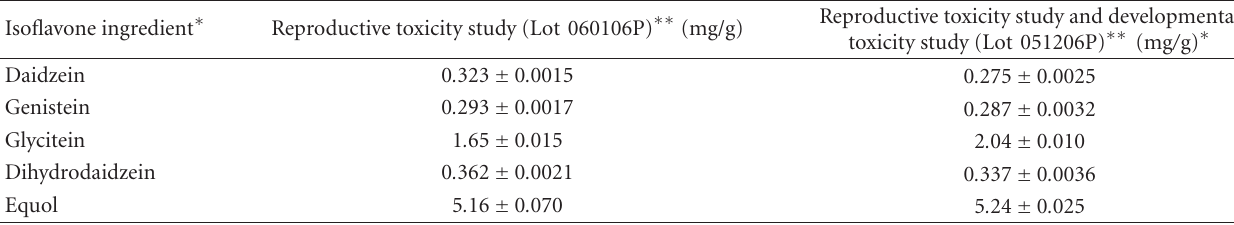
Table 1: Isoflavone constituents of SE5-OH.